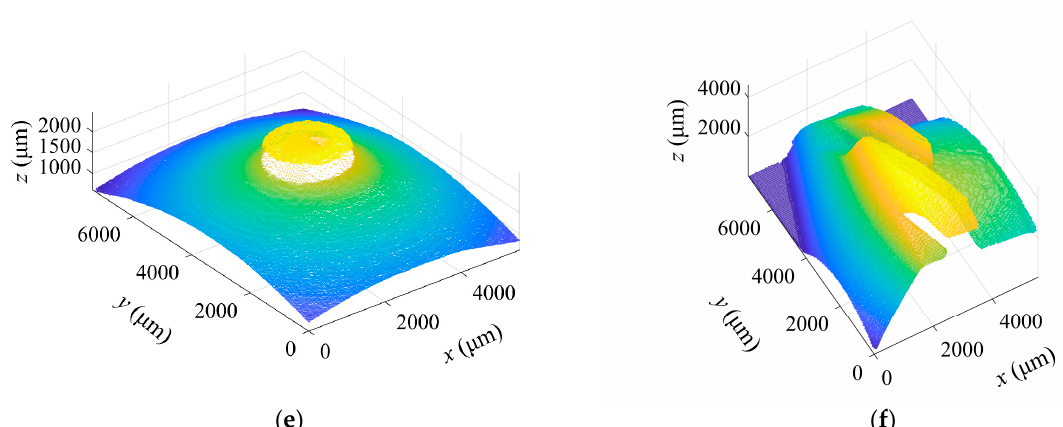
Figure 16. Point clouds from the different methods. ( a , b ) are measured by the traditional SFF; ( c , d ) are measured by the proposed SFF; and ( e , f ) are measured by an laser scanning microscope.